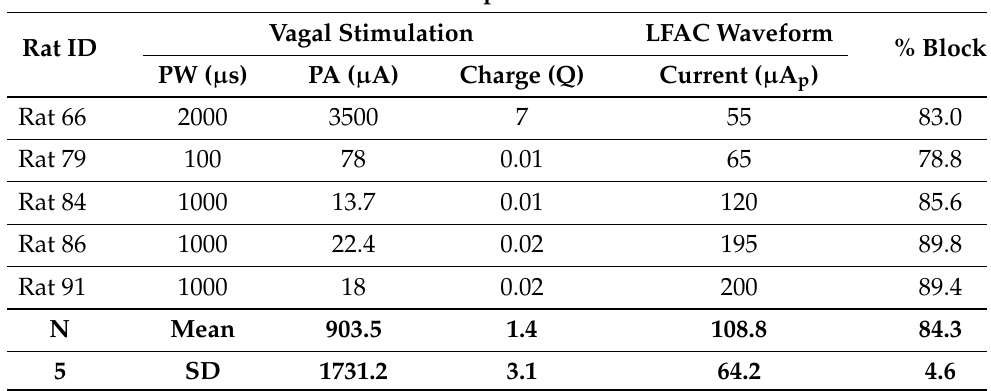
Table 2. Vagal stimulation and LFACb waveform parameters when LFACb was delivered via a bipolar cuff electrode. An average of 84.3 ± 4.6% block was achieved in the ‘LFACb+VStim’ epoch of the test